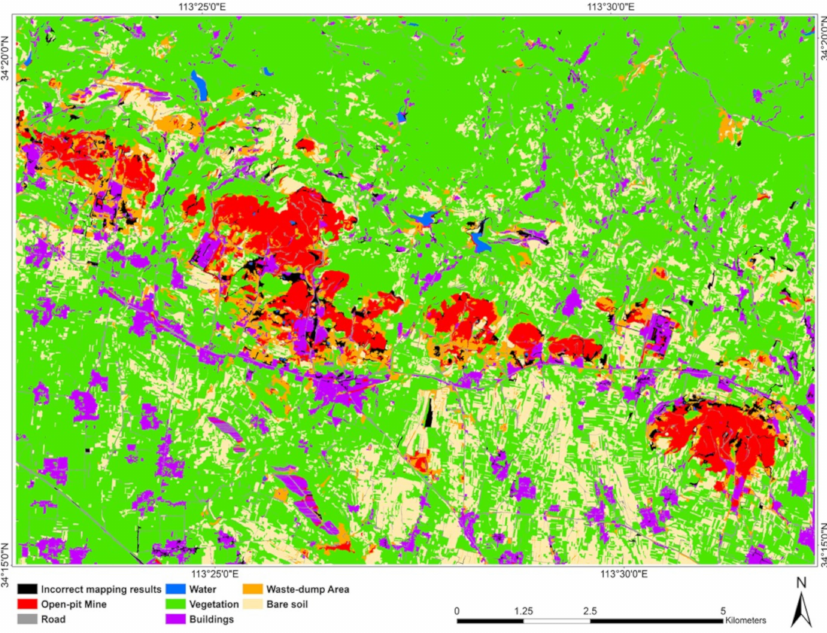
Figure 12. Results of LUCs identification and incorrect identifications of CNNOMM.